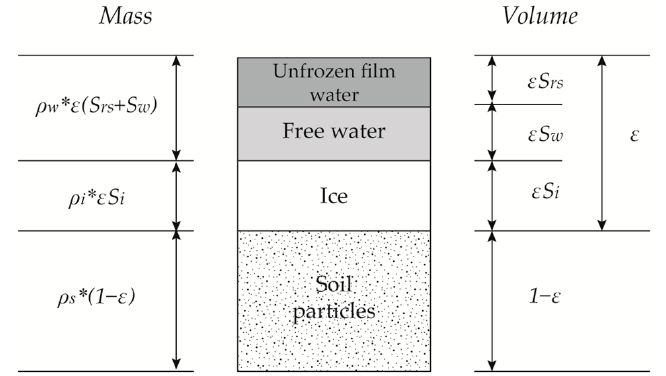
Figure 1. Schematic of a typical phase diagram for the freezing process.